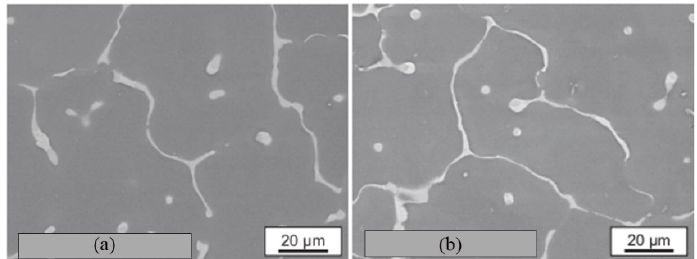
Figure 6. SEM images of some Mg–Ca–Zn as-cast alloys: ( a ) Mg-1.6Ca-0.8Zn; ( b ) Mg-1.6Ca-1.8Zn [36].